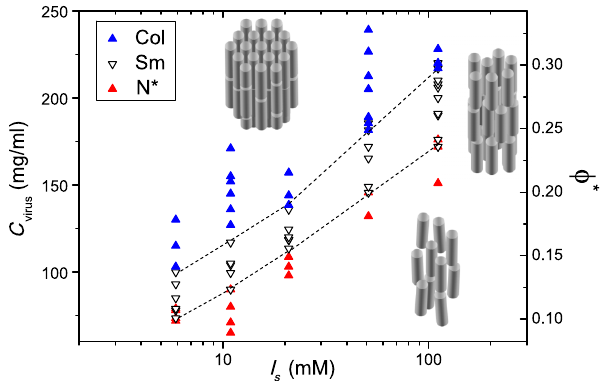
FIG. 1. Experimental phase diagram of the dense liquid- crystalline states of fd virus suspensions. The reduced rod packing fraction ϕ (cid:1) is plotted as a function of the added salt I s . The dashed lines are a guide for the eye to indicate the N-Sm and Sm-Col phase transitions, where the smectic range (open white symbols) includes both the smectic-A and the smectic-B mesophases (see text).